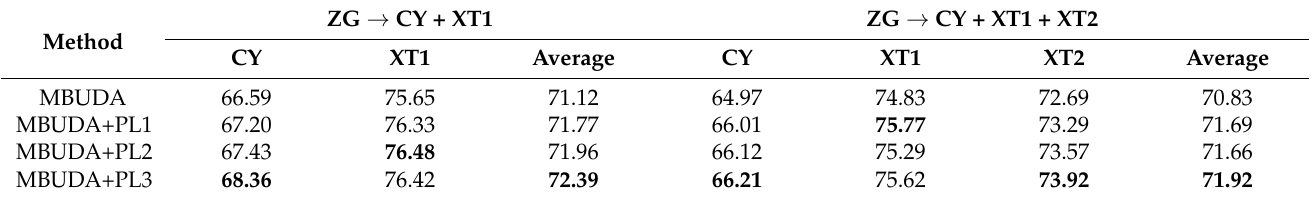
Table 6. Additional impact of pseudo labels. the results are based on the IoU of the orchard